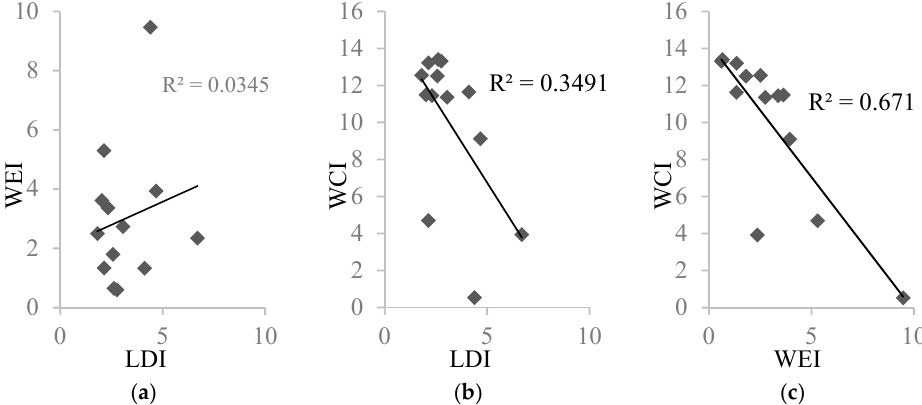
Figure 7. Linear regressions between the wetland condition index (WCI) and the values of the sub-indices in urbanized regions (Xianhe and Baixiang). Panel A shows the relationship between the LDI and WEI ( n = 13). Panels ( a – c ) show the relationships between the WEI and LDI, the WCI and LDI, and the WCI and WEI ( n = 13), respectively.